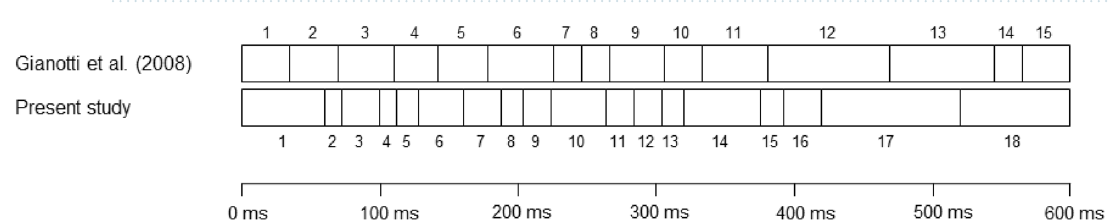
Figure 1. Change in subjective emotional arousal ratings depending on block and valence. Black horizontal lines within the box indicate the median, upper and lower box limits the upper and lower quartile, bold dots outside the whisker indicate outliers, i.e. 1.5 interquartile ranges from the box. Ratings of every participant are shown as a scatterplot along the whisker. Significant differences as computed with the Tukey’s Test are indicated by * ( p < 0.001). Y-axis ticks were relabeled (“− 200” as “0”, “200” as “400”) for contentual logic.